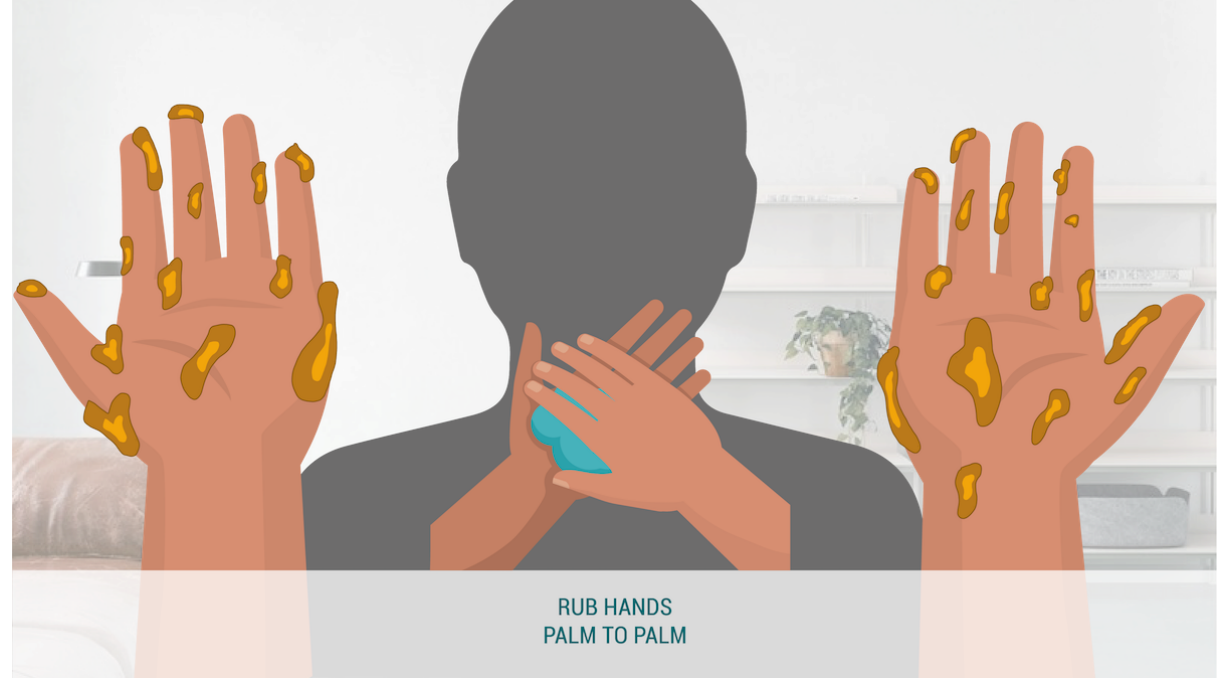
Figure 8. Avatar